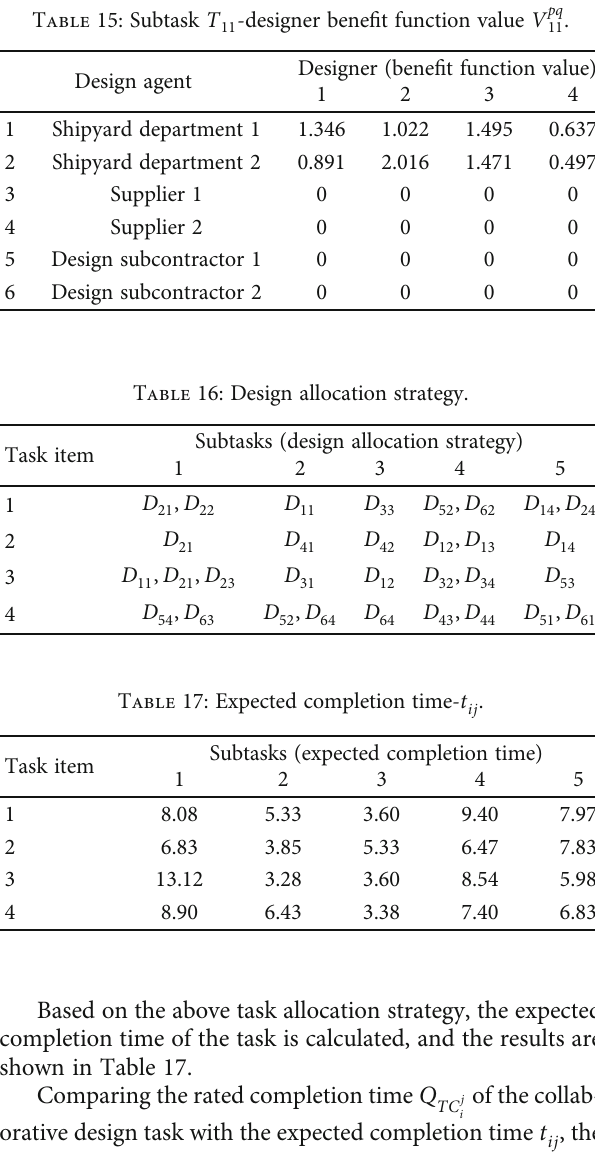
fi t function value V pq